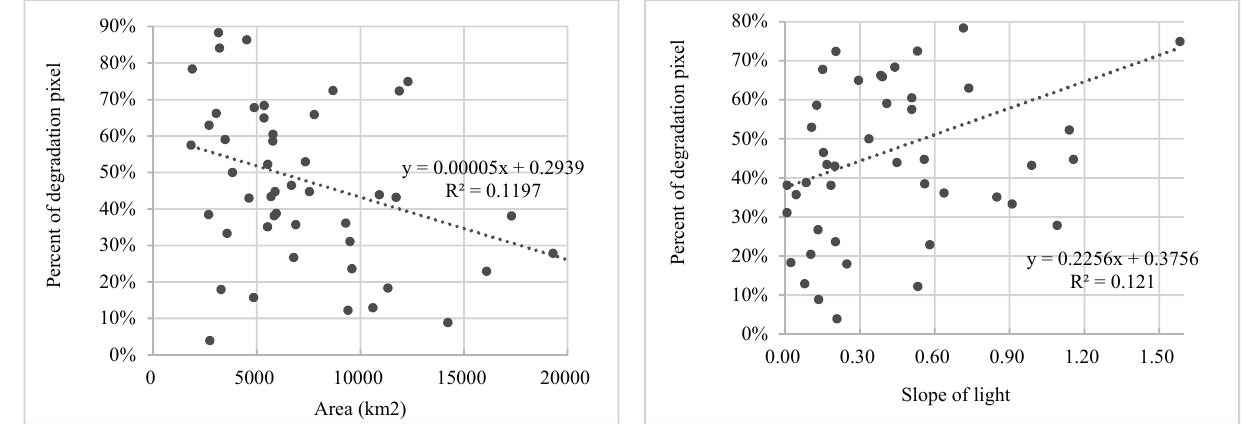
Figure 9. The relations among urbanization area, percent of degradation pixel, and slope of light in all 50